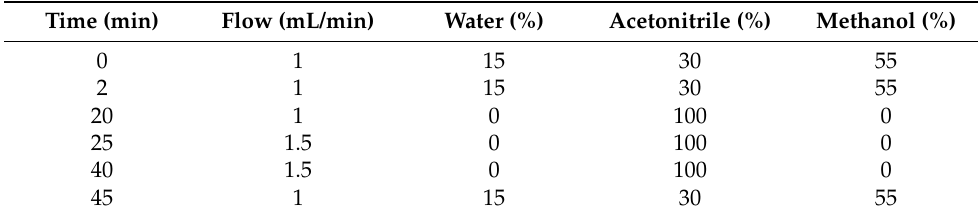
Table 1. Mobile-phase elution gradient.